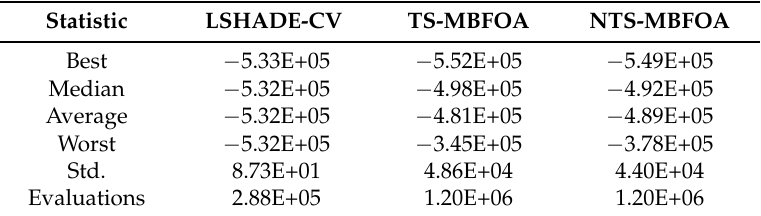
Table 5. Basic Statistics of the results obtained by TS-MBFOA and NTS-MBFOA compared against an Evolutionary Algorithm. Std is the standard